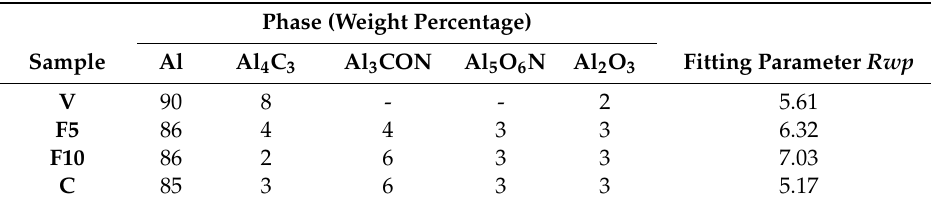
Table 3. Weight percentage of the phases in the di ff erent sintered samples.